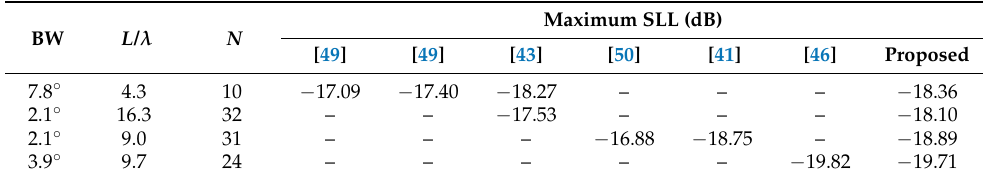
Table 1. PS: performance comparison between different algorithms.